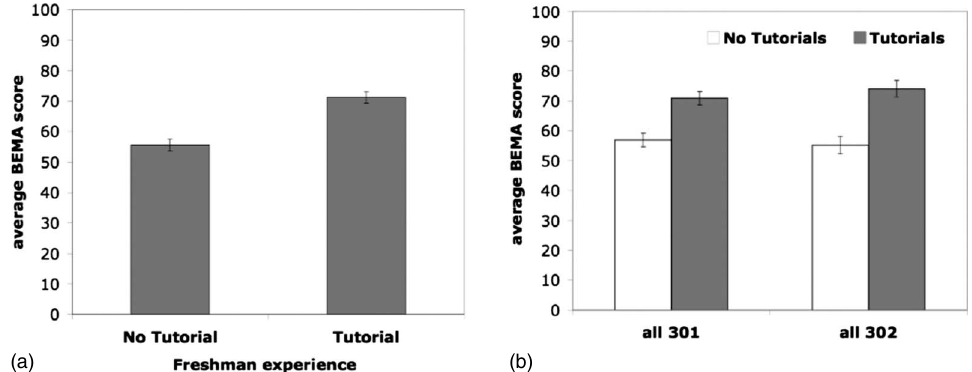
FIG. 1. BEMA scores after upper-division E&M. Fig. a (cid:1) left (cid:2) shows averages over both upper division courses. The left bin shows BEMA scores for students who had never been through a Physics II Tutorial environment. The data are averaged over seven terms (cid:1) Fa04-Fa07 (cid:2) and two courses (cid:1) 301 and 302 (cid:2) , representing N =100 individuals with BEMA postscores. On the right are those students who had gone through a freshman Tutorial experience. (cid:1) N =67 (cid:2) The difference (cid:1) (cid:6) 15 % (cid:2) is significant. Fig b (cid:1) right (cid:2) separates data for Phys 301 and 302. Errors are standard error of